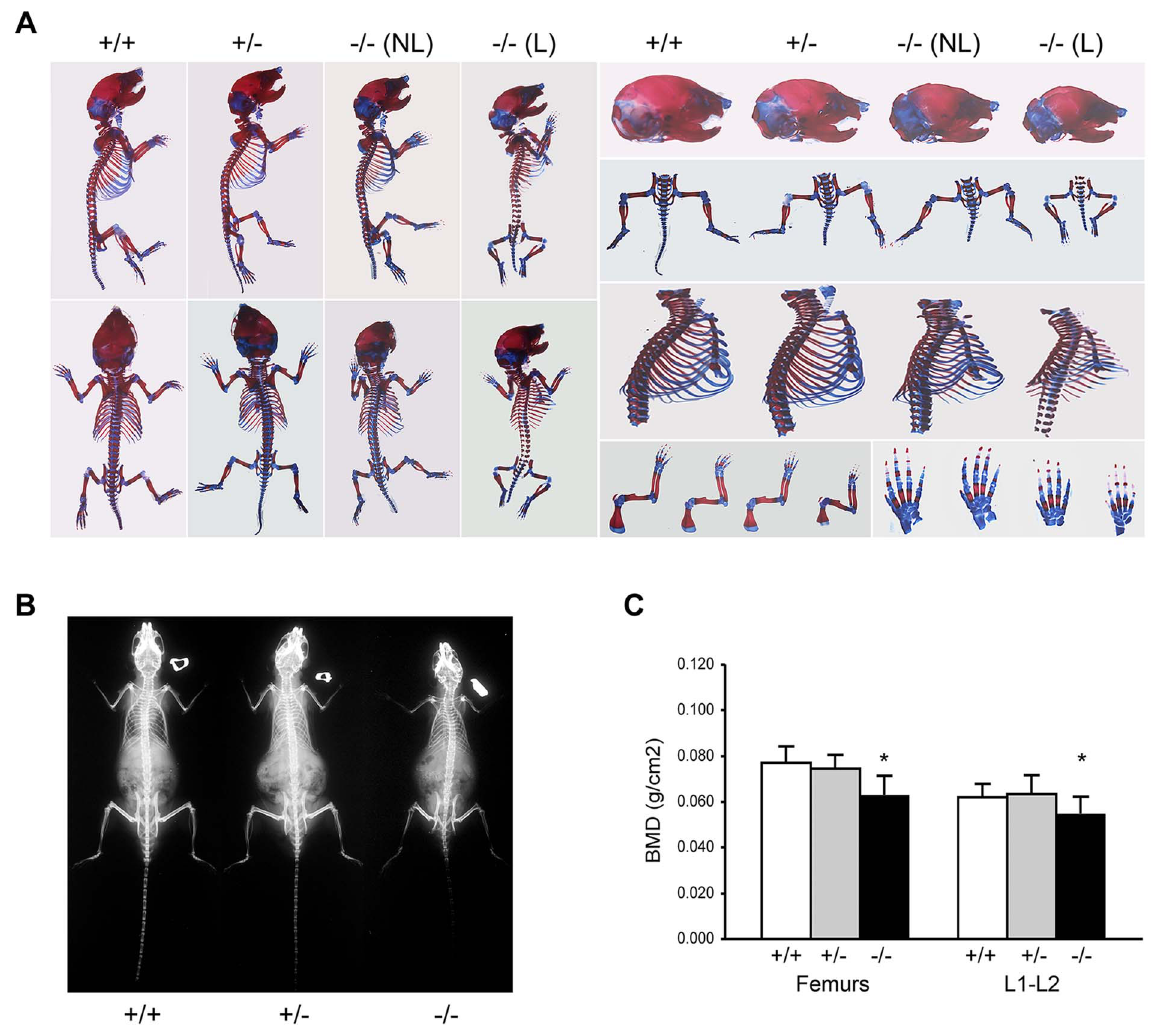
Figure 2. Absence of Ppib expression affects bone development. (A) Staining of newborn skeletons with Alizarin red (bone) and Alcian blue (cartilage) reveals undermineralization of calvaria and ribs. Homozygous mice have smaller size of whole skeleton and long bones, and a deformed rib cage. (B) X-rays of 8 week-old mice. (C) DXA analysis of 8 week-old mice (n=10/genotype).